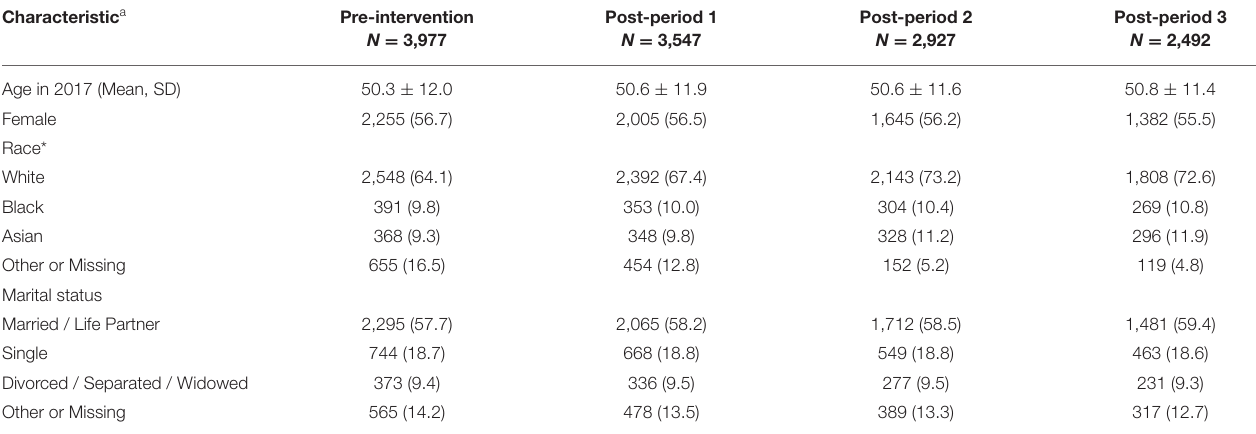
TABLE 1 | Sociodemographic and diagnostic characteristics of KSU employees across study periods. Characteristic a